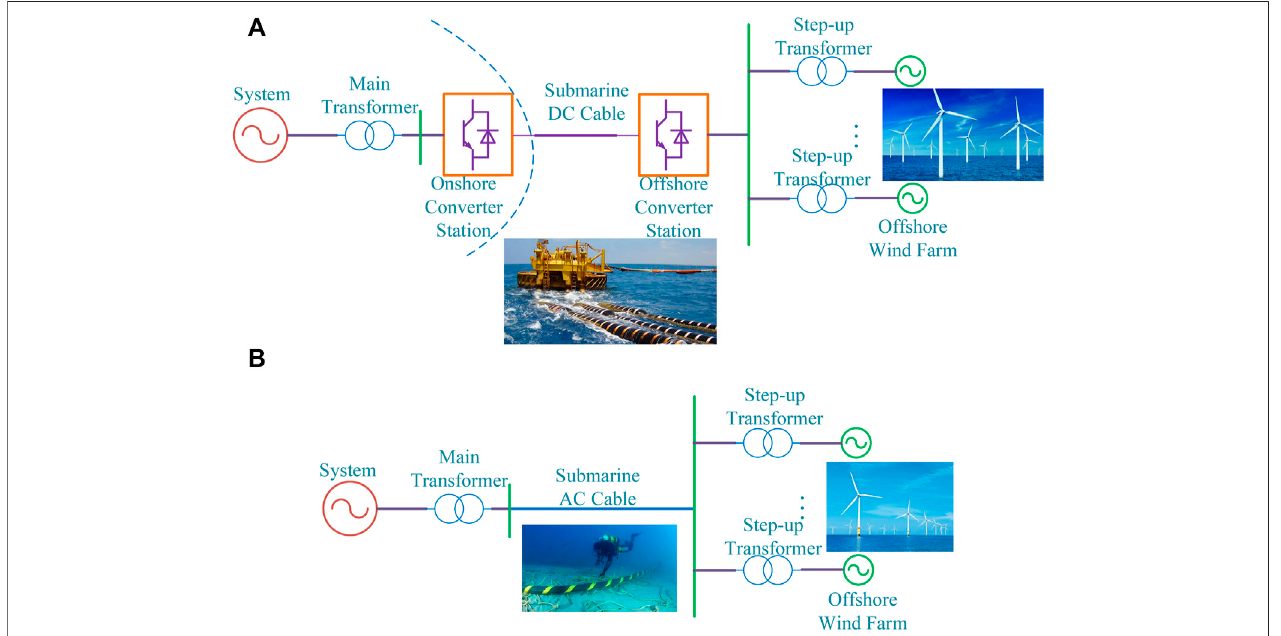
FIGURE 1 | Offshore wind farms with voltage source converter type (VSC-HVDC) and high voltage alternating current (HVAC) transmission methods.